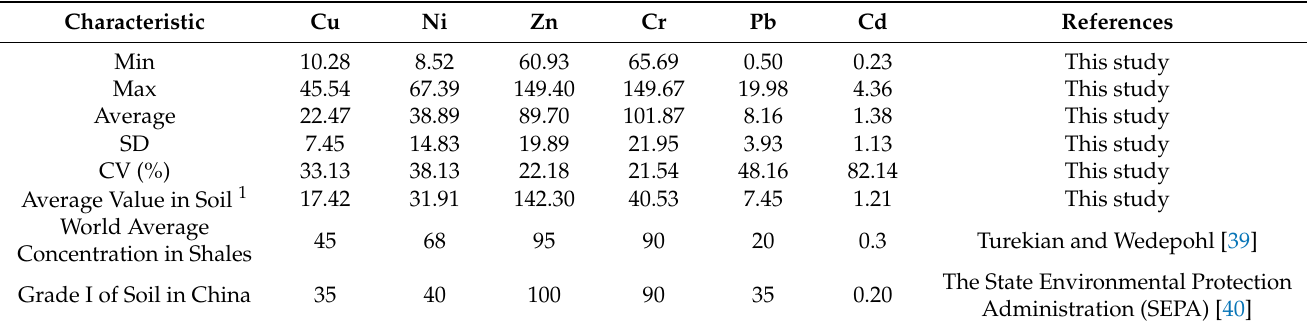
Table 1. Statistic characteristics of heavy metals in sediments from Inner Mongolia section of Yellow River and refences (sample numbers = 37; unit: mg/kg).